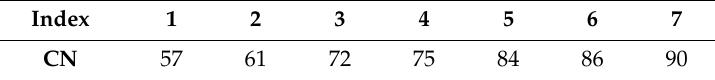
Table 2. Infiltration index and related curve